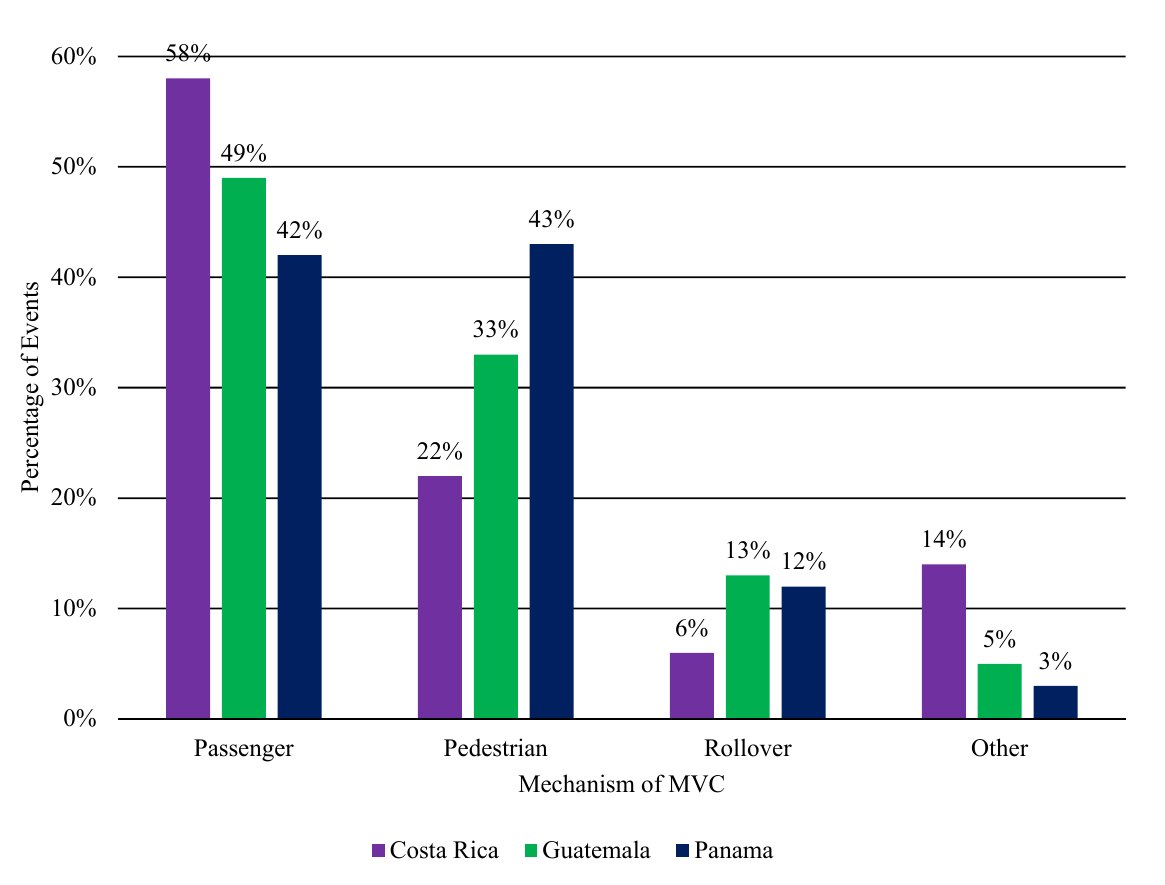
Figure 1. Most frequent type of MVCs in Costa Rica, Guatemala, and Panama 2012–2015. Abbreviation: MVC, motor vehicle collision.